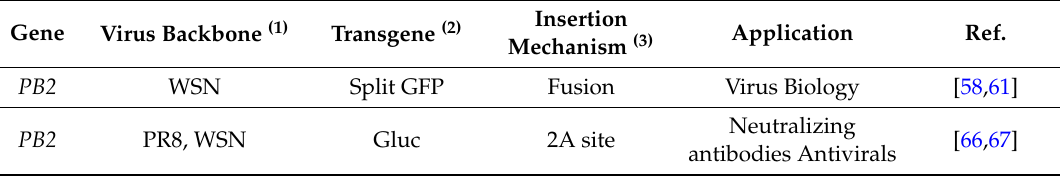
Table 2. Influenza A viruses with reporter genes in the PB2 viral segment. Insertion Application Ref. Gene Virus Backbone (1) Transgene (2) Mechanism (3) PB2 WSN Split GFP Fusion Virus Biology [58,61] Neutralizing PB2 PR8, WSN Gluc 2A site antibodies Antivirals